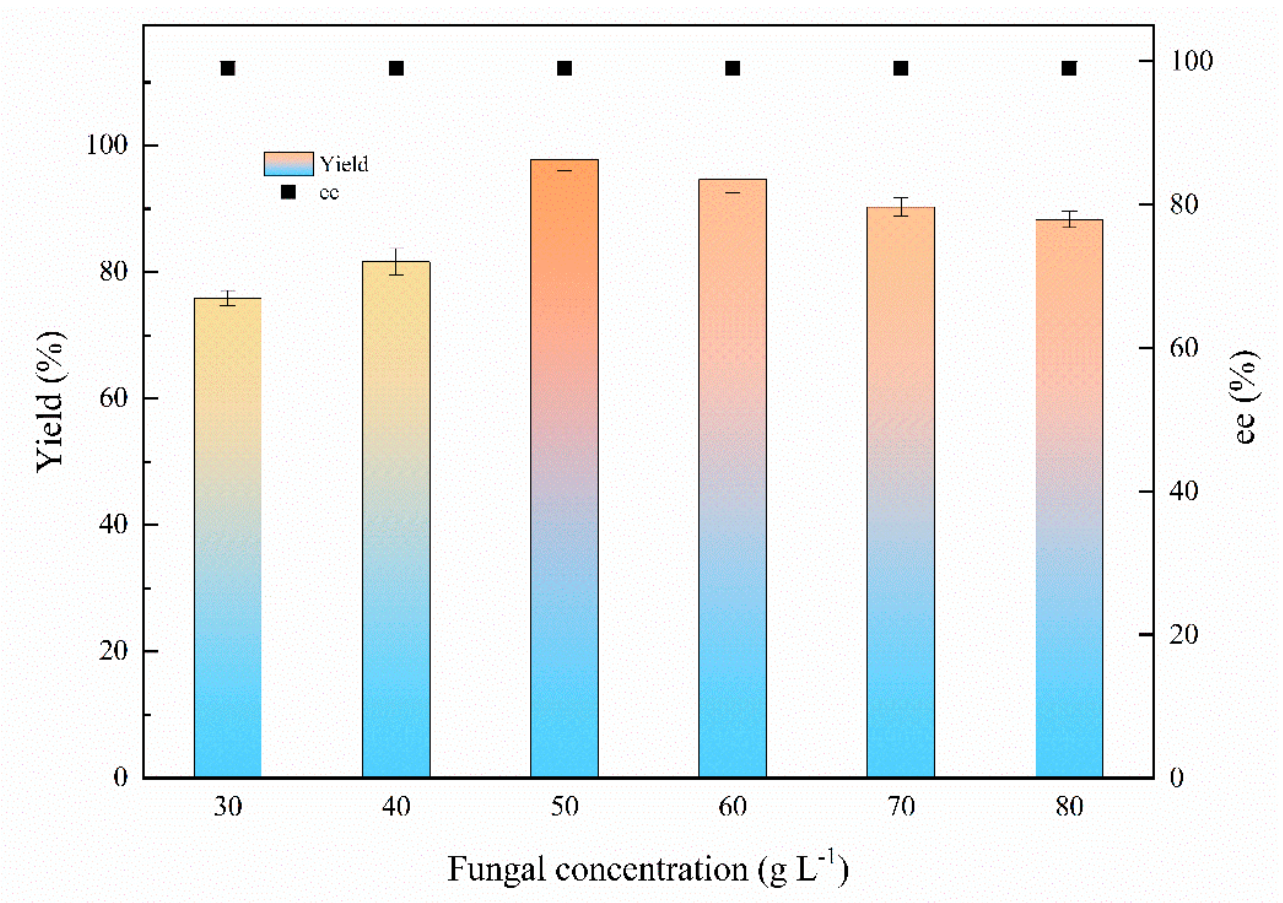
Figure 5. Effects of fungal concentration on the biocatalytic reduction. Reaction conditions: 20.0 mL K 2 HPO 4 -KH 2 PO 4 (100 mM, pH 6.0), 30–80 g L − 1 resting cells (DCW), 50 mM 1-chloro-2-heptanone, 15% ( v/v ) IPA, 200 rpm, 30 °C, 24 h.